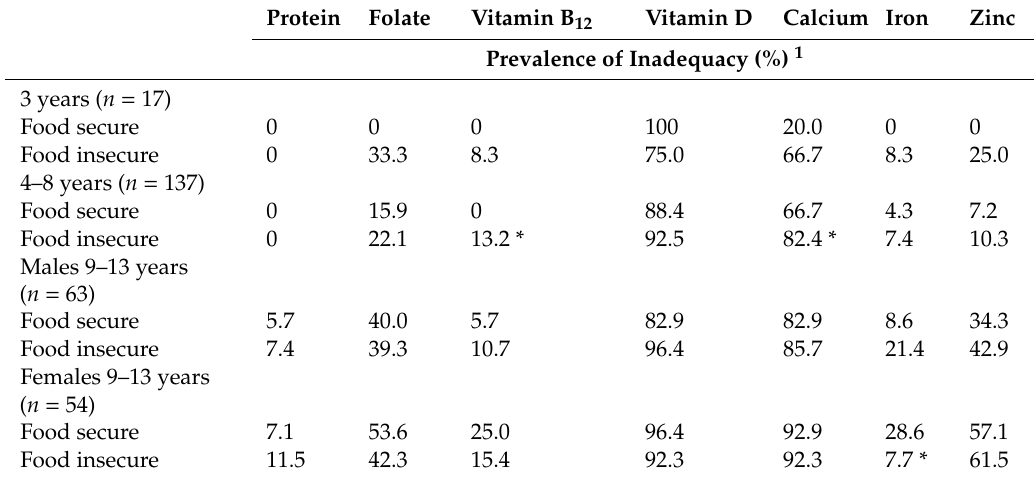
Table 6. Prevalence of inadequacy among children for select nutrients ˆ. Protein Folate Vitamin B 12 Vitamin D Calcium Iron